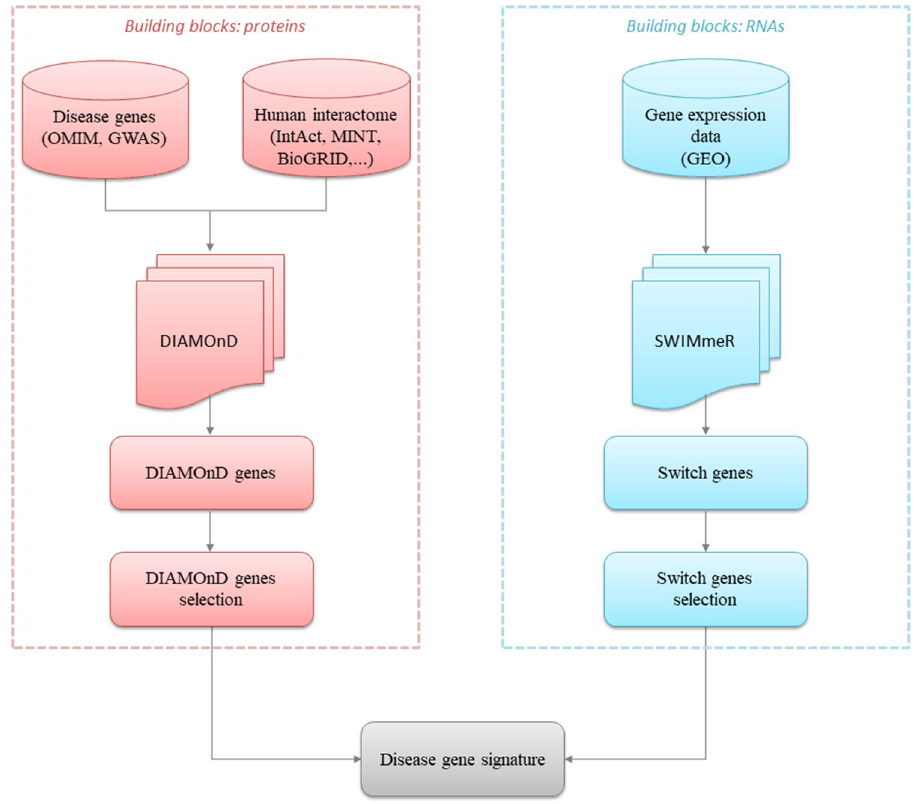
Figure 2. Study design. The figure depicts the schematic of the analysis applied in this